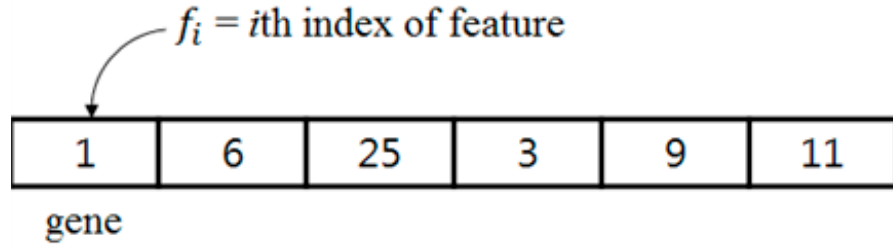
Figure 3. An example of permutation